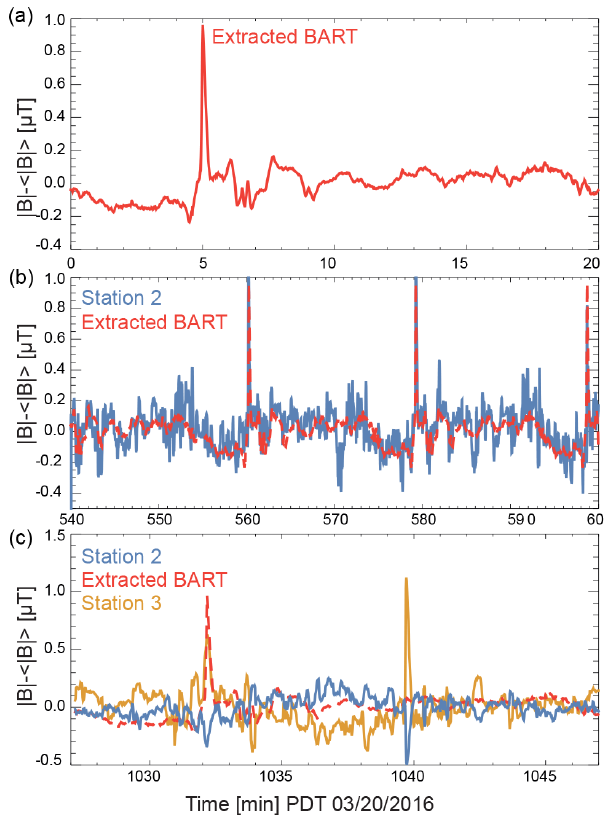
Figure 9. Extraction of BART signal. (a) The 20min periodic sig- nal of the BART extracted from an ensemble average of 46 inter- vals from station 2. (b) Comparison of the extracted average signal with an hour of observations from station 2 taken from 09:00 to 10:00PDT. (c) Comparison of extracted average signal with an in- terval containing a global magnetic anomaly likely due to variation in BART